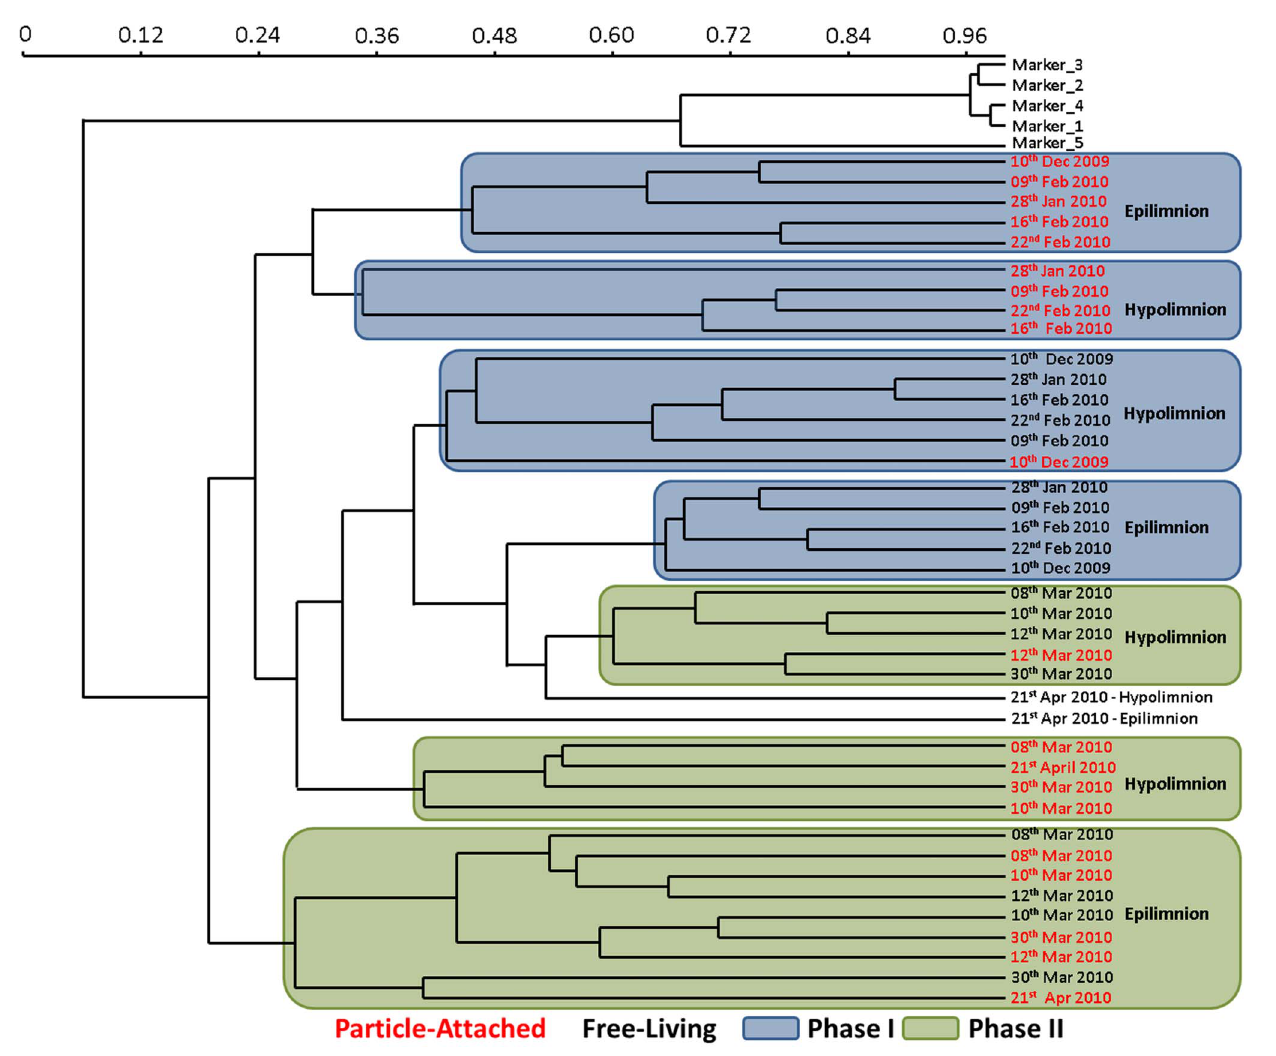
Figure 4. Denaturing gradient gel electrophoresis dendrogram showing the relationship between particle-attached and free-living bacterial communities from epilimnion and hypolimnion of Lake Stechlin during Phase I and Phase II of the bloom. The gels were analyzed using the Phoretix 1D version 11.4 (TotalLab) software and cluster analysis was done with PAST3 [25] using the Bray-Curtis similarity